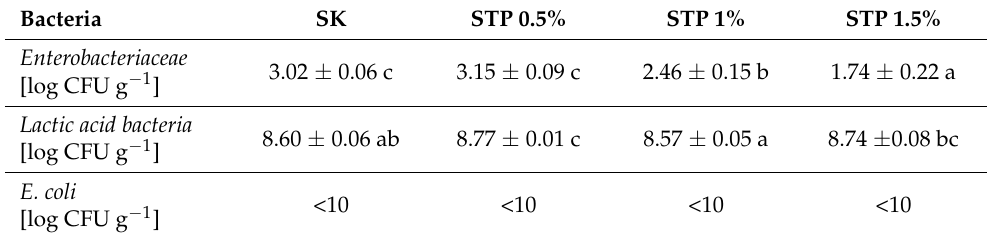
Table 6. The results of microbiological analyses of dry fermented sausages. Bacteria